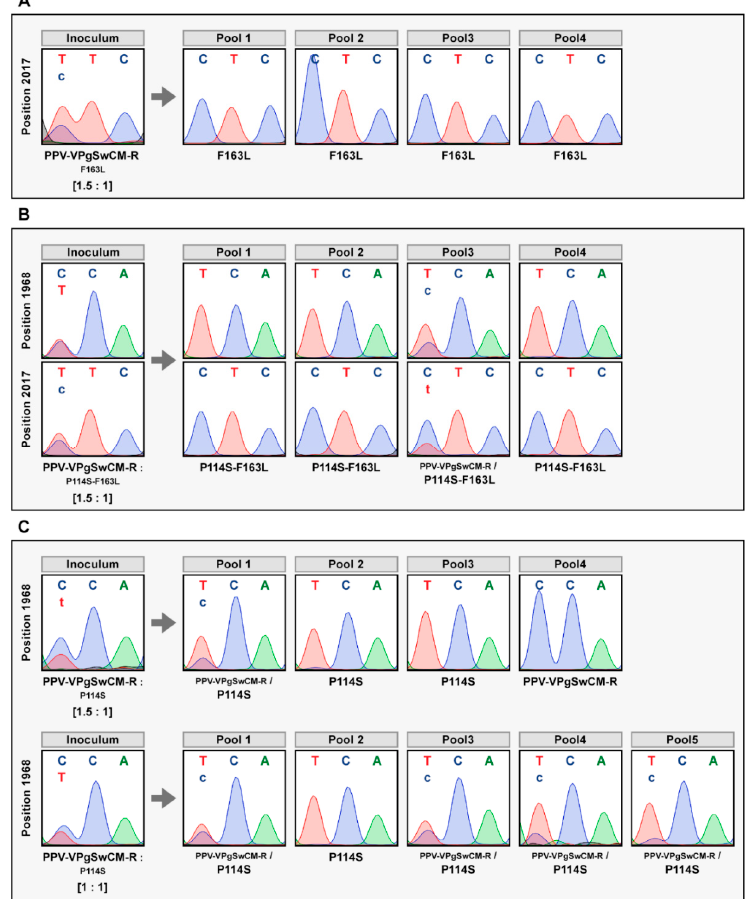
Figure 3. Sequence analysis of viral progeny from Nicotiana clevelandii exposed to mixed infections with competing viruses. N. clevelandii plants, 8 or 10, were inoculated by hand rubbing with mixtures containing DNAs of pICPPV-VPgSwCM-R DNA and of one version of this chimera modified with the mutation F163L ( A ), P114S plus F163L ( B ) or P114S ( C ). Non-mutated/mutated chimera mixtures at 1.5:1 ratio, were employed for the three competitions. An additional 1:1 ratio mixture was used for the PPV-VPgSwCM-R vs P114S competition. Viral progenies were analyzed in pools of two plants by reverse transcription-polymerase chain reaction (RT-PCR) amplification and sequencing of a DNA fragment covering the VPg coding sequence. Images show the chromatograms of VPg codons 163 (position 2017–2019 in the viral genome) and/or 114 (position 1968–1970 in the viral genome). Viruses identified are indicated beneath the chromatograms; smaller letters indicate lower accumulation. A similar result was obtained in a replicate assay.